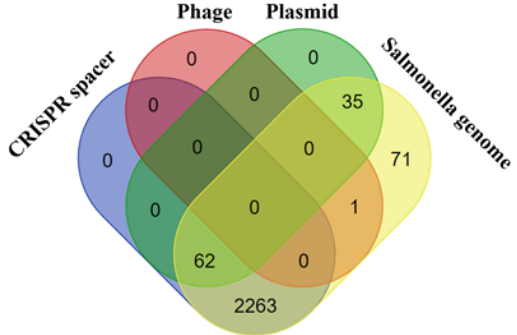
Figure 4. Homology of CRISPR spacers for the Salmonella isolates studied.